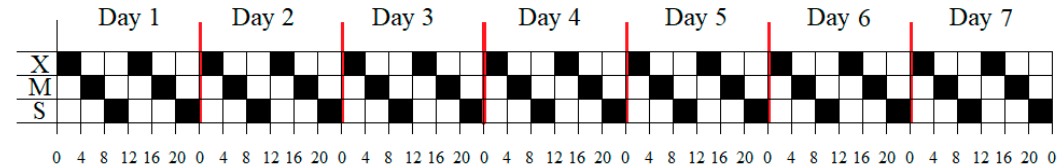
Figure 4. Official working hours X—Coxswain, M—Mechanic, S—Sailor, ( ■ )—Work and ( □ )—Rest/Sleep.